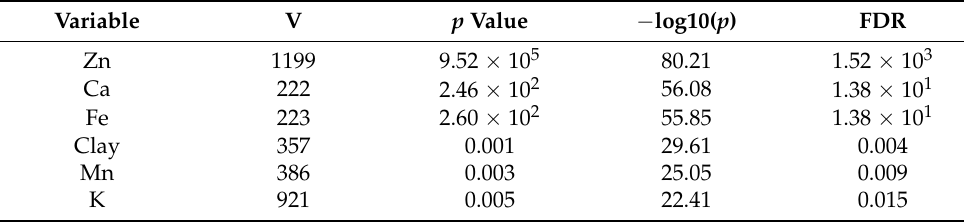
Table 1. Important variables selected by Wilcoxon Rank Test with threshold 0.05.